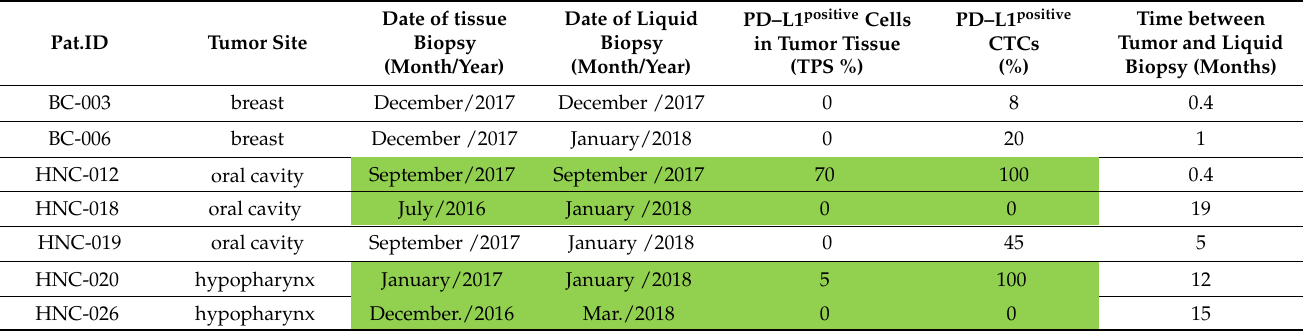
Table 2. PD – L1 expression in tumor tissue and CTCs. Results from cases with ≥ 3 CTCs and available matched tumor tissue are presented. Concordant cases are highlighted in green (TPS: tumor proportion